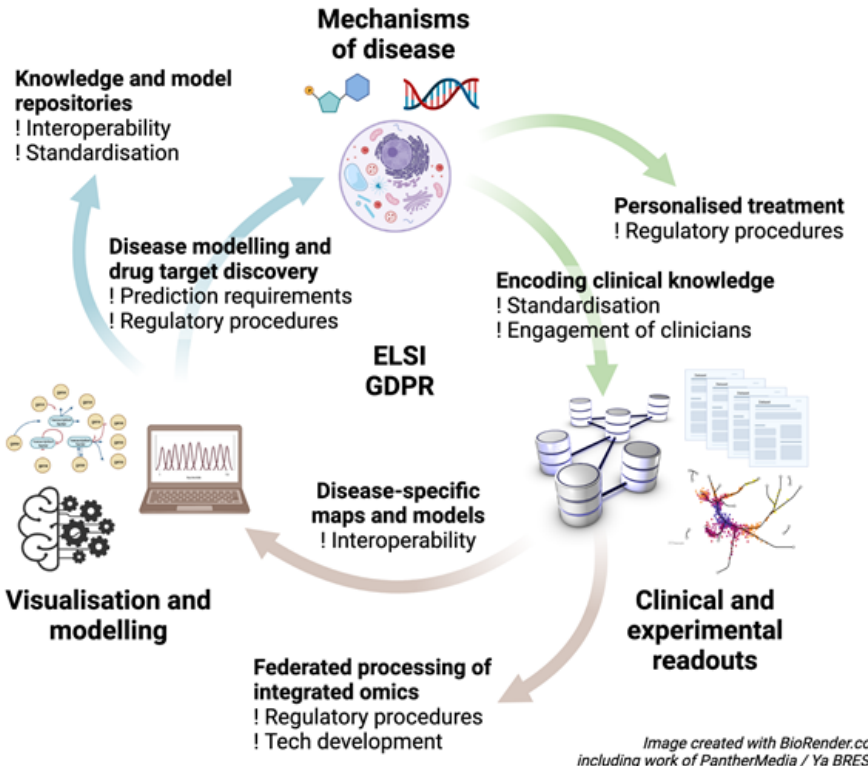
Figure 2. Illustration of the key areas of systems medicine (building on Figure 1). Encoding clinical knowledge; federated processing of integrated omics data; construction of disease-specific maps; construction of knowledge and model repositories in the area; and disease-specific modelling and drug target discovery leading to the development of personalised treatments based on models of disease mechanisms. Underpinning all of these is the need to work within ELSI and GDPR